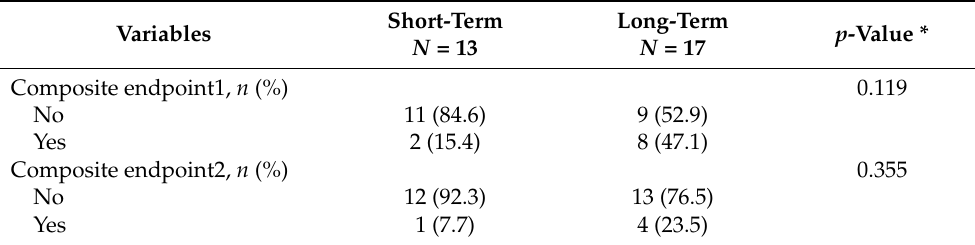
Table 3. Clinical outcomes of COVID-19-infected patients between the short- and long-term NSAIDs- use